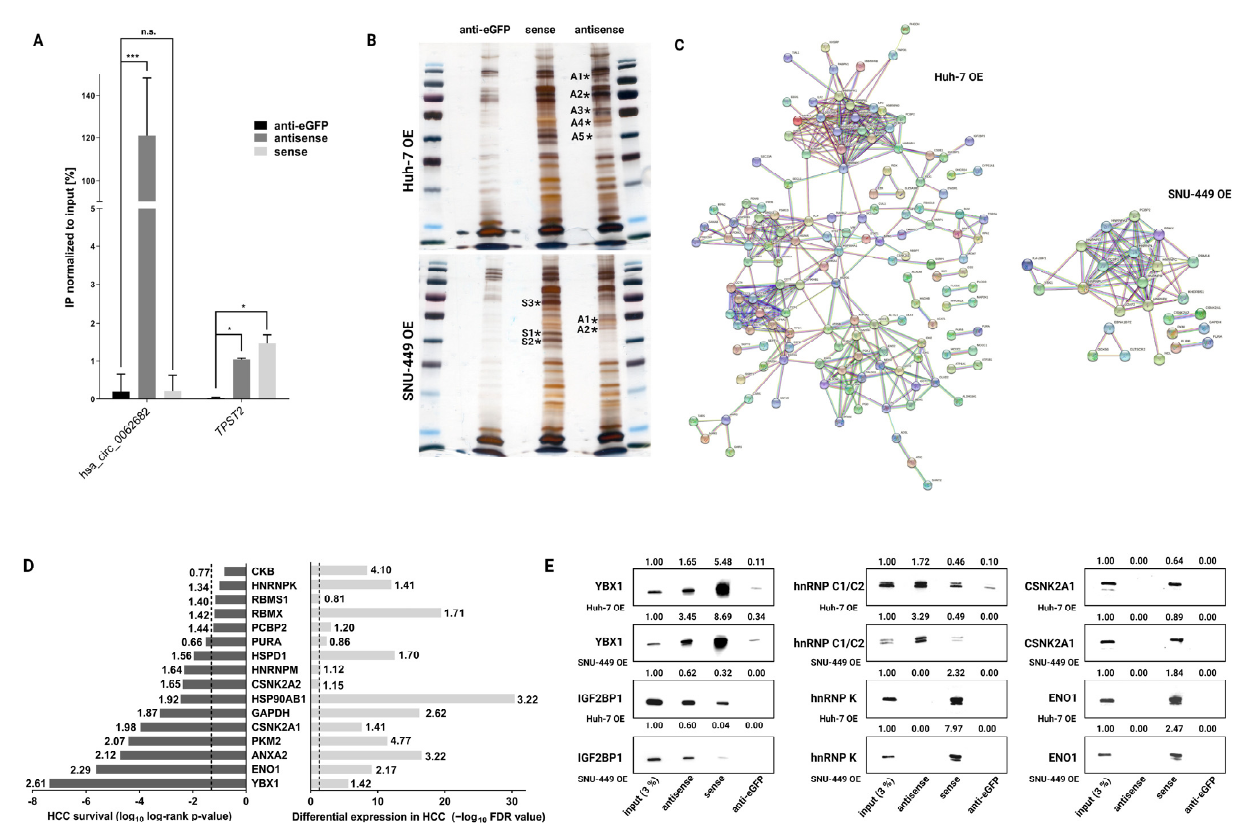
Figure 6. Biotinylated oligonucleotide pulldown of hsa_circ_0062682 coupled with mass spectrometry identifies its potential protein binding partners. ( A ) Confirmation of a specific pulldown by RT-qPCR (n = 3) in Huh-7 OE cell line; ( B ) silver staining of biotinylated oligonucleotide pulldowns in Huh-7 OE ( top ) and SNU-449 OE ( bottom ) cell lines (* indicates excised bands for mass spectrometry analysis; letters and numbers indicate excised bands indicated in Table S9); ( C ) functional protein network analysis in STRING database of identified proteins by mass spectrometry (minimum 2 unique peptides present); ( D ) alignment of top identified proteins by mass spectrometry with differential expression in HCC ( right : numbers indicate fold change ratio between the tumour and normal samples) and with overall survival of HCC patients ( left : numbers indicate hazard ratio); dotted line indicates p -value ≤ 0.05; ( E ) Western blotting of potential protein binding partners in biotinylated oligonucleotide pulldowns of both stable overexpressing cell lines; numbers indicate densitometric analysis of presented bands normalized to the input. OE: overexpression. Results are represented as averages and error bars represent standard deviation. The uncropped blots are shown in Supplementary Data.